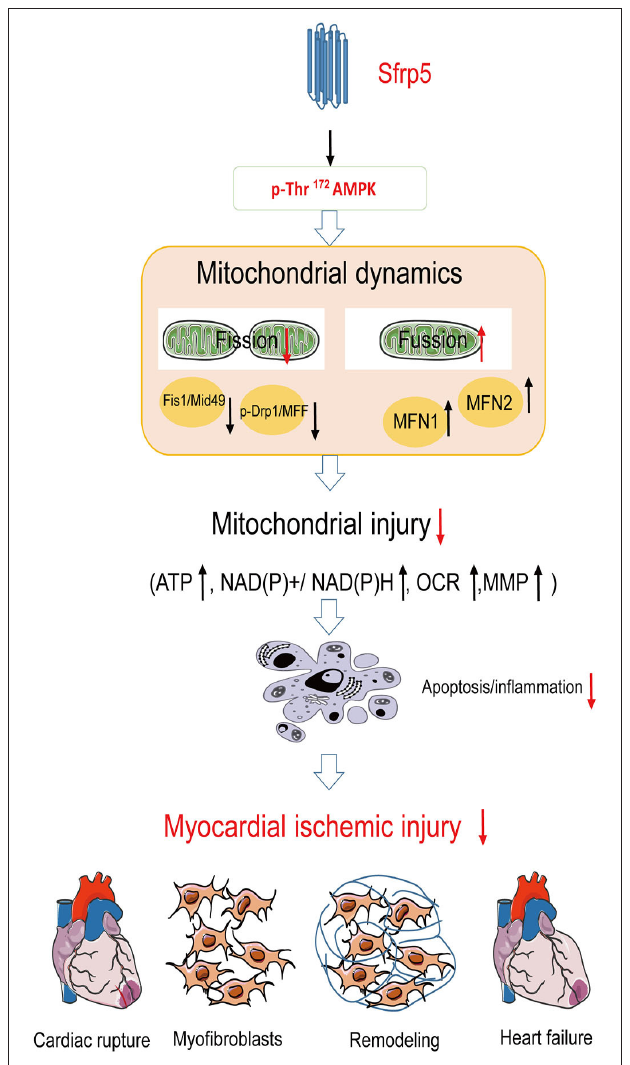
FIGURE 7 | Summary of Sfrp5 effects and the proposed mechanism of Sfrp5 effect on MI and mitochondrial dysfunction. Sfrp5 protected against ischemic injury and attenuated cardiac remodeling through mitochondrial function improvement partly via activating the AMPK signaling.